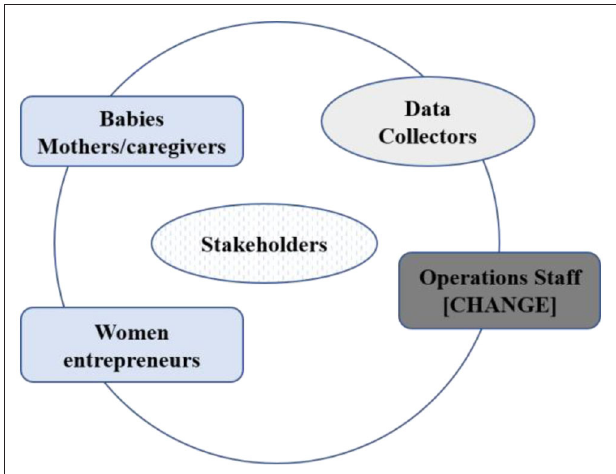
FIGURE 2 | Schematic showing the structure of the learning and feedback loop. The MEL plan has 4 levels that are interconnected; Level 1: Operations Level, 2: Women Entrepreneurs, Level 3: Babies Caregiver/Mother, and Level 4: Data